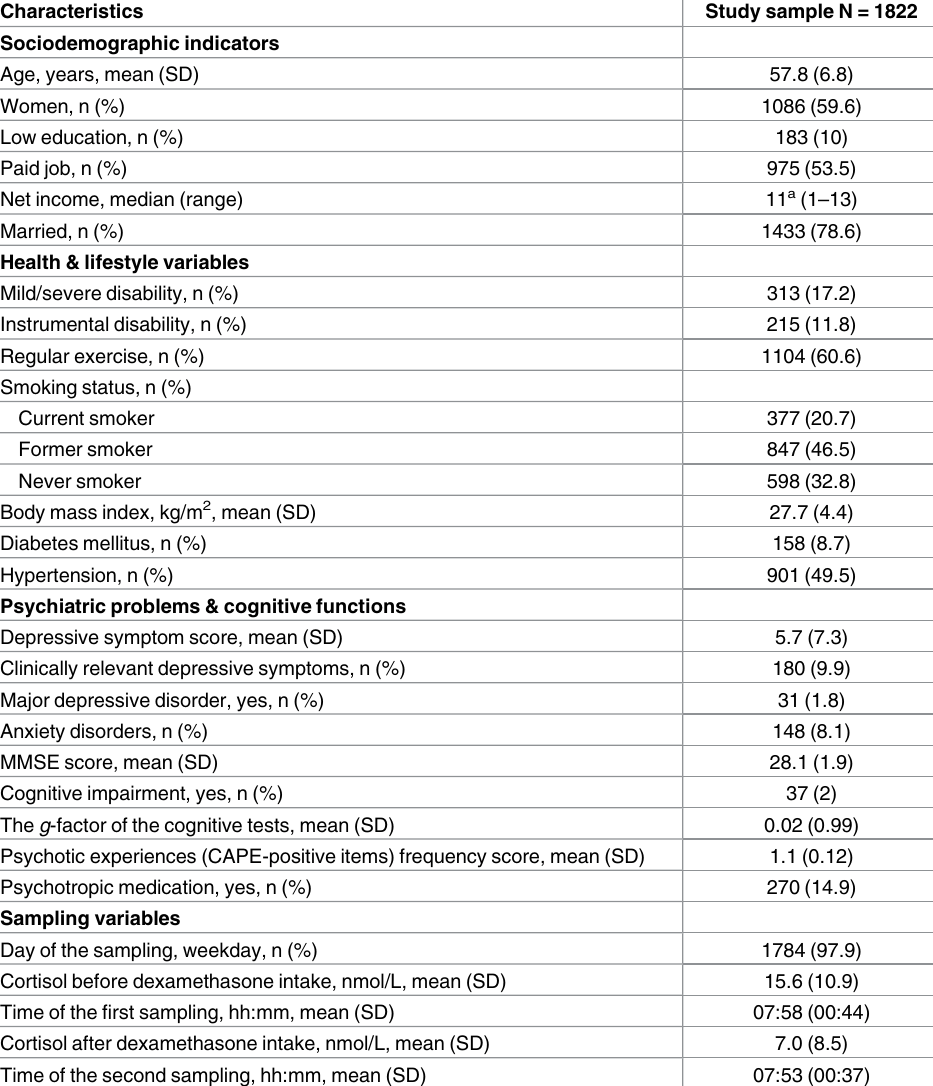
Table 1. Characteristics of the study